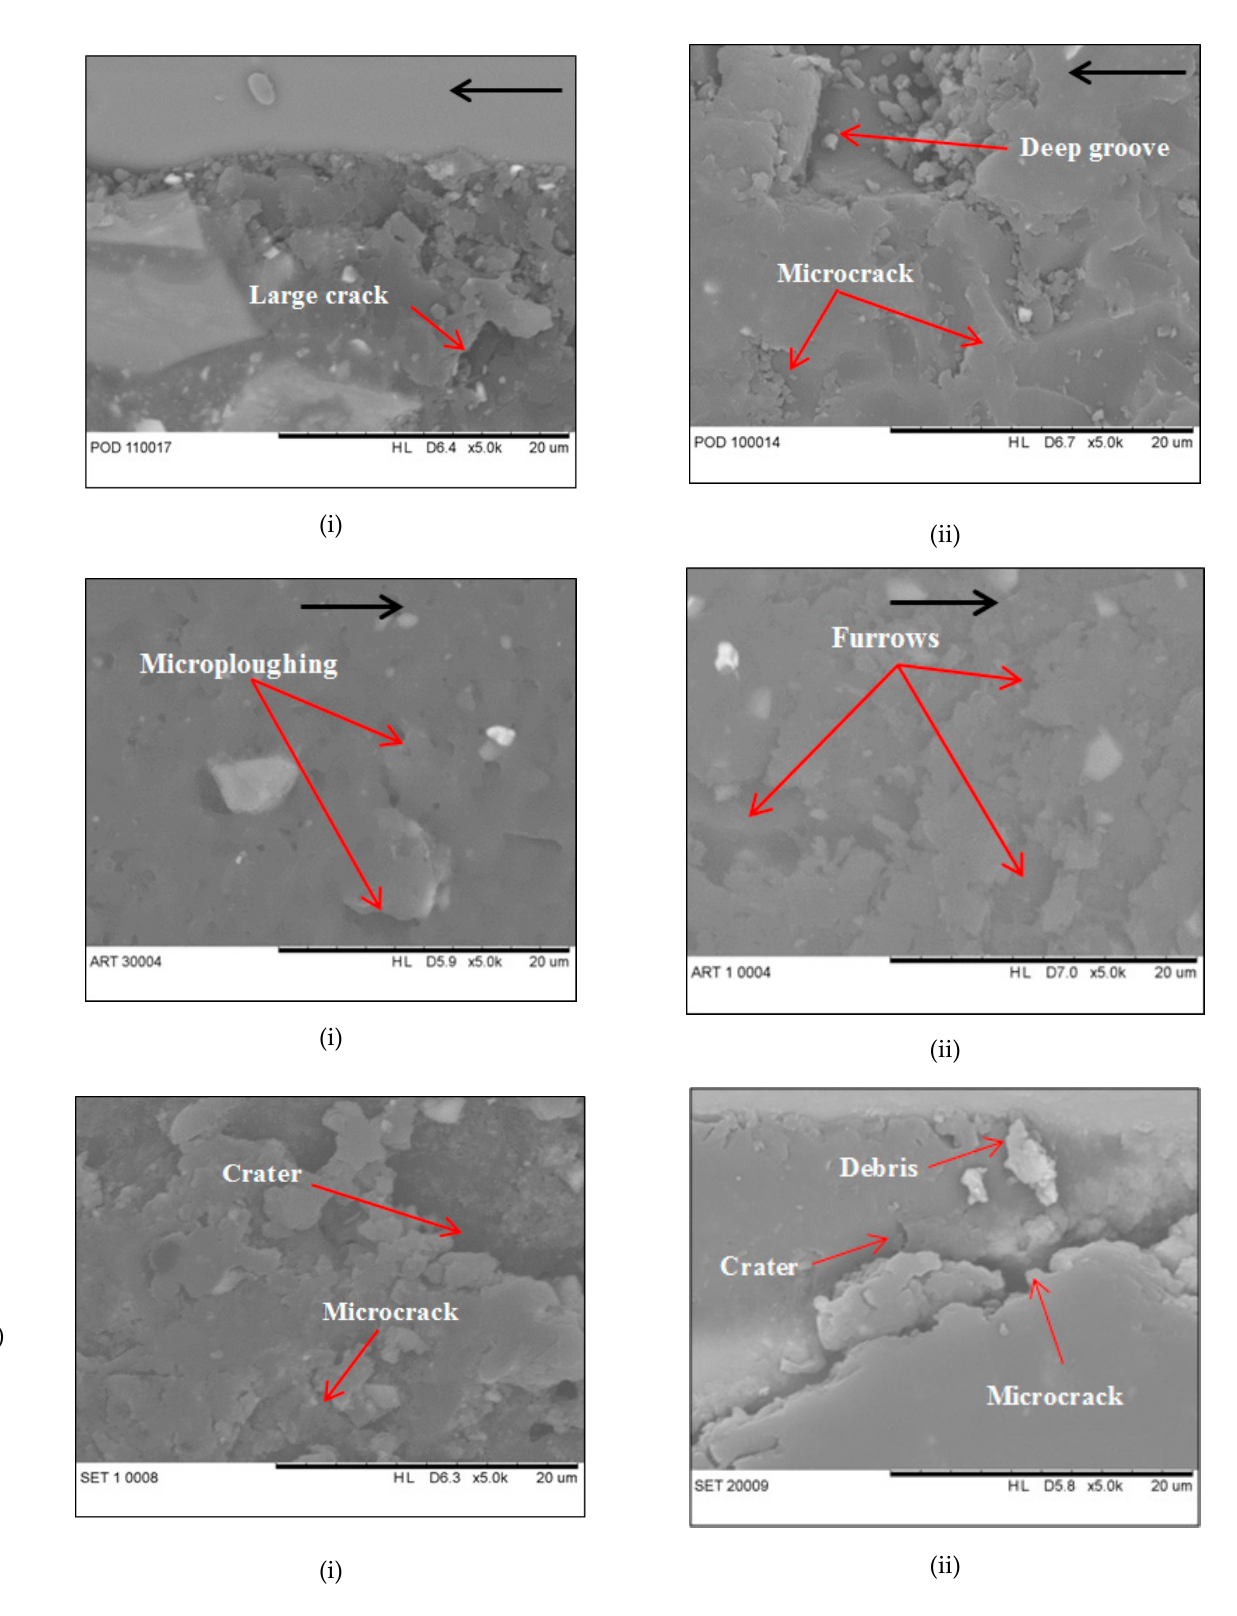
Figure 3. SEM micrograph of worn surface of (i) EP/GF and (ii) EP/BF composites after 10 km travel distance at ( a ) adhesive, ( b ) abrasive and ( c ) erosive wear condition.